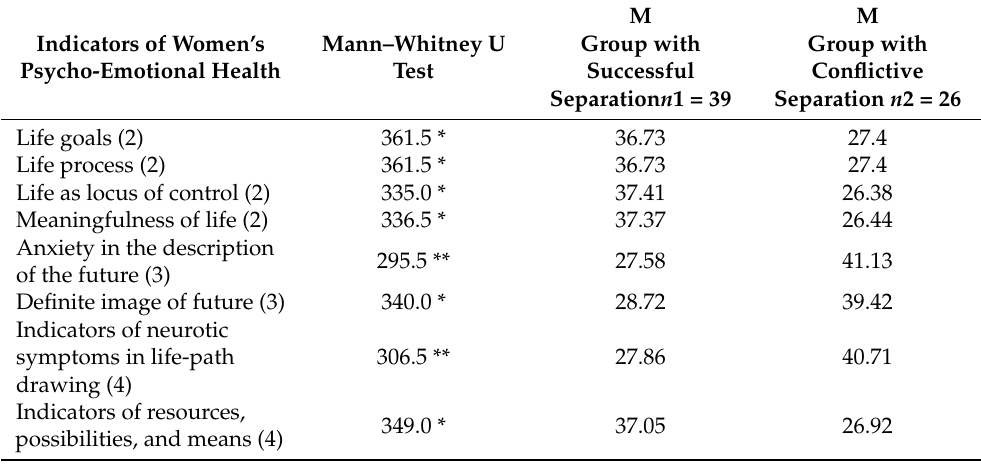
Table 3. Differences in the indicators of psycho-emotional health in middle-aged women with a successful ( n 1 = 39) and a conflictive ( n 2 = 26) type of separation from mothers.